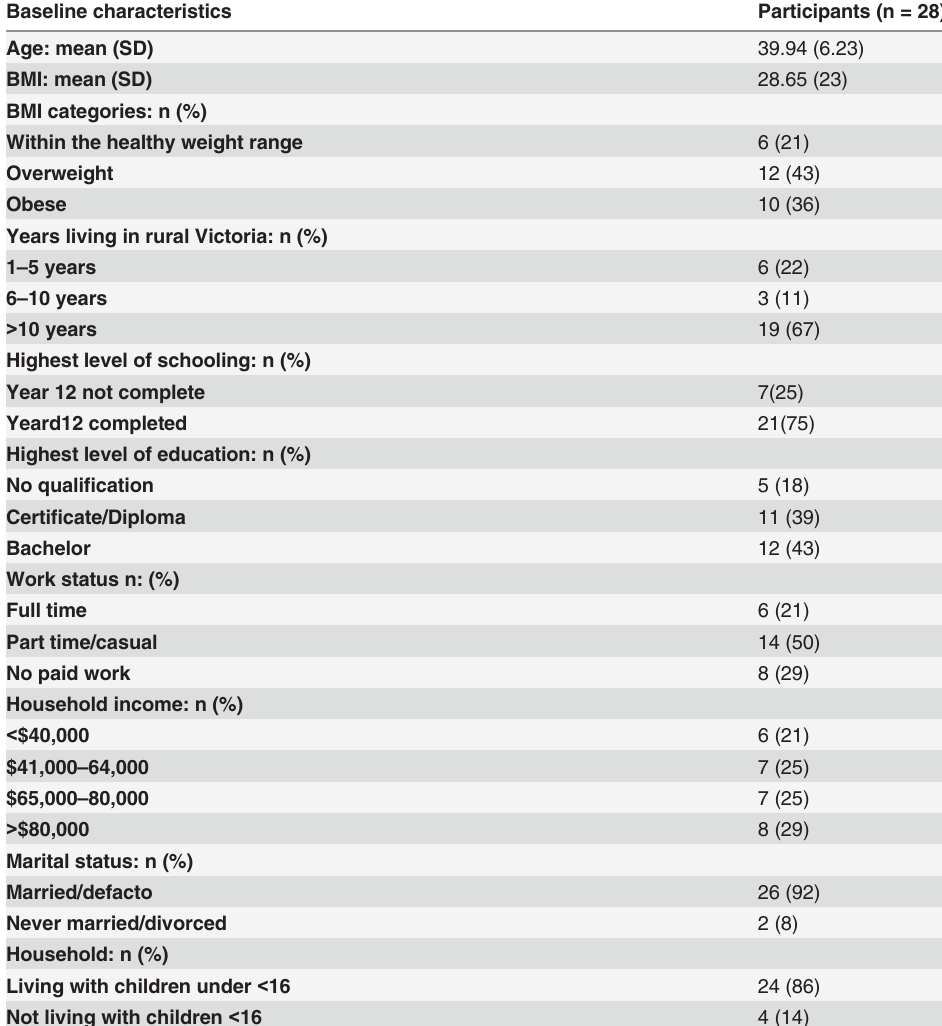
Table 1. Demographic and anthropometric characteristics of participants. Baseline